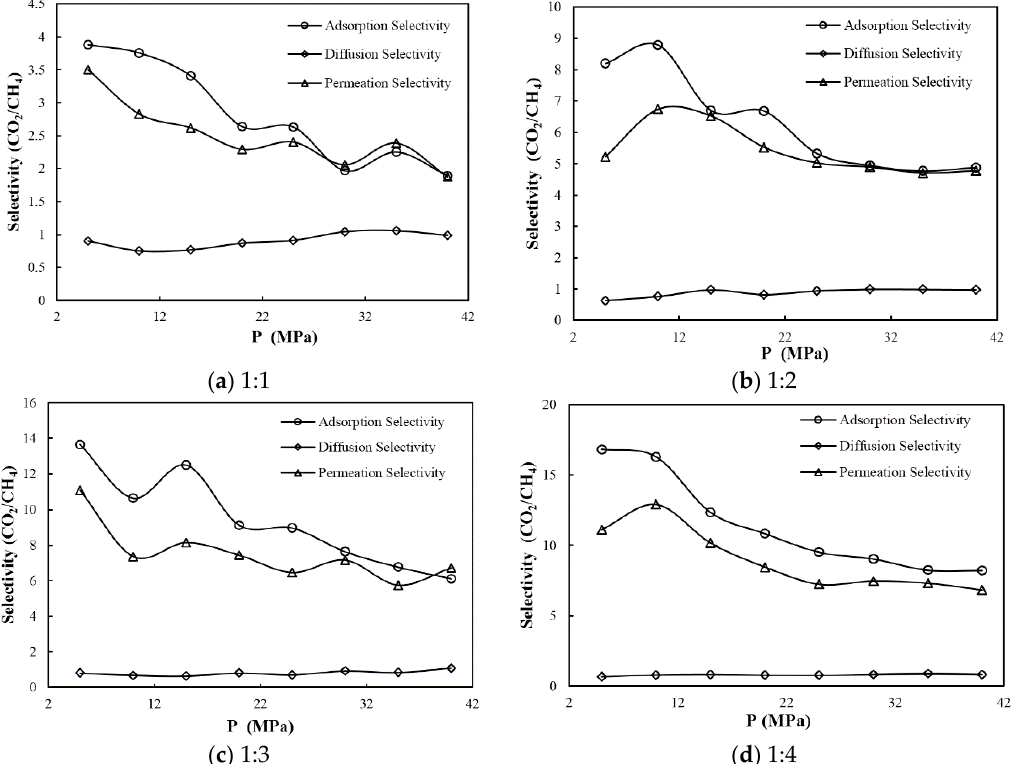
Figure 8. Adsorption, diffusion and permeation selectivity of CH 4 /CO 2 .